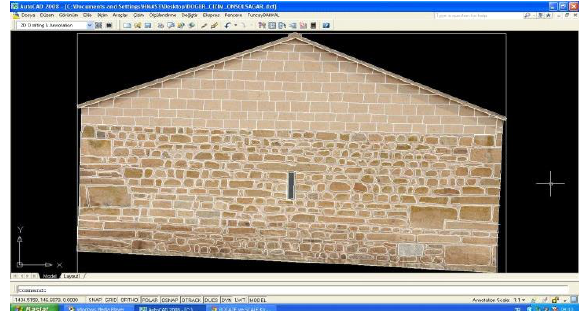
Figure 5. Covered surface frontline